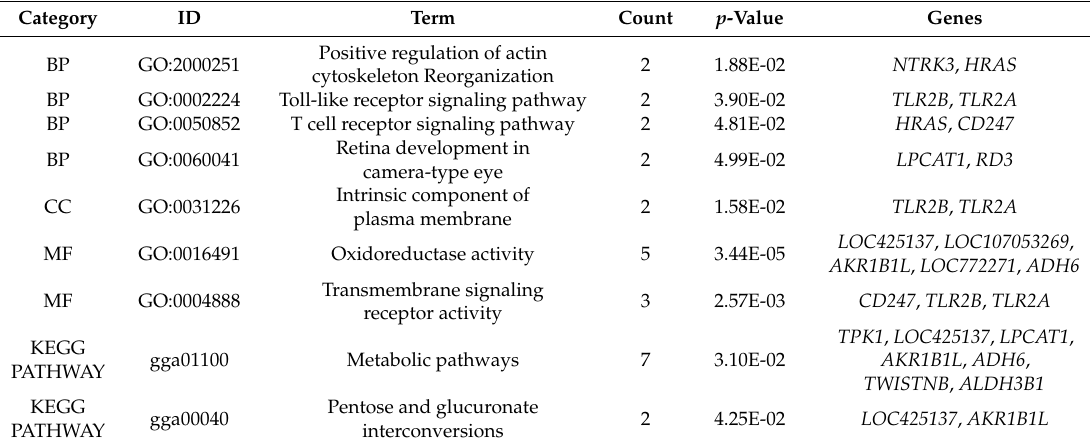
Table 2. Functional annotation of genes with significant di ff erences in copy number between breeds ( p -value <